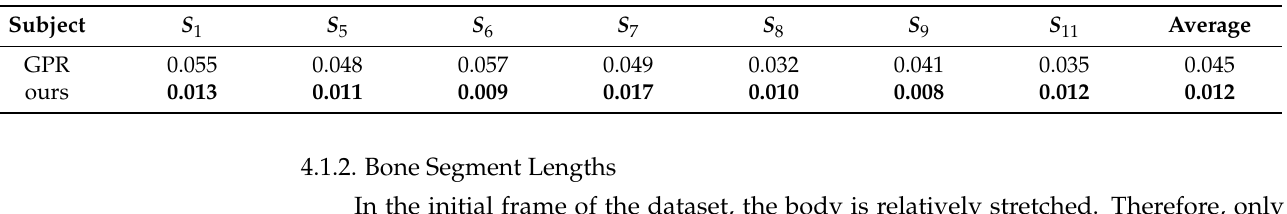
Table 3. Results of Bone proportion recovery (ground truth 2D points). The spine is set as scale 1. GPR is the method proposed by [31] (Bold indicates higher accuracy).